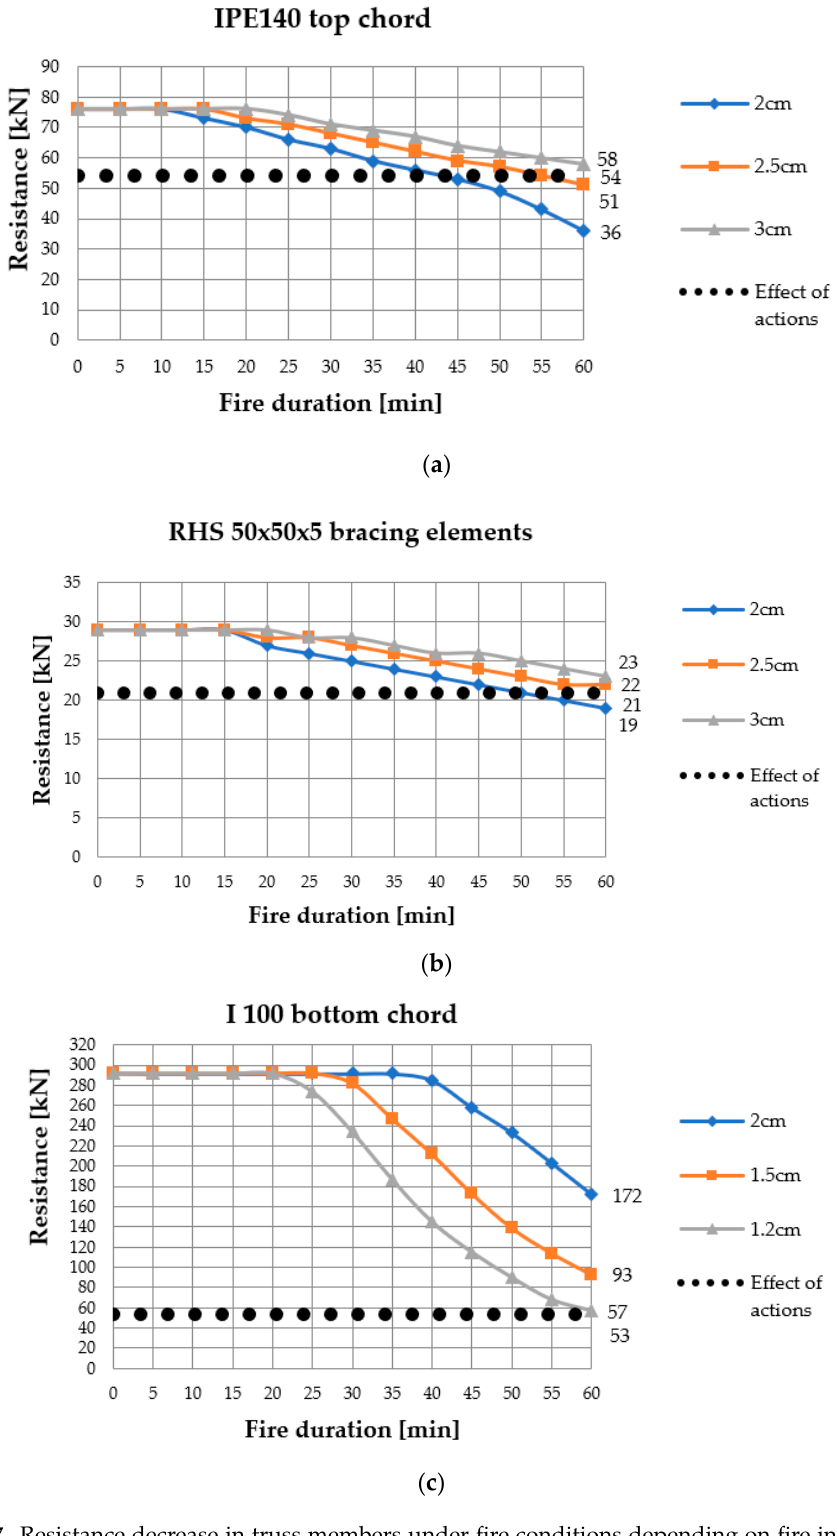
Figure 7. Resistance decrease in truss members under fire conditions depending on fire insulation thickness: ( a ) I 100 bottom chord, ( b ) RHS 50x50x5 bracing elements , ( c ) IPE 140 top chord. According to charts in Figure 7, the thickness of fire insulation was altered. For the top chord it was increased to 3 cm; for bracing elements it was increased to 2.5 cm. The insulation thickness of the tension elements of the bottom chord was decreased to minimum value of 1.5 cm (Table 3) to reduce the costs of fire protection. Finally, the structure reached the R60 fire resistance class.